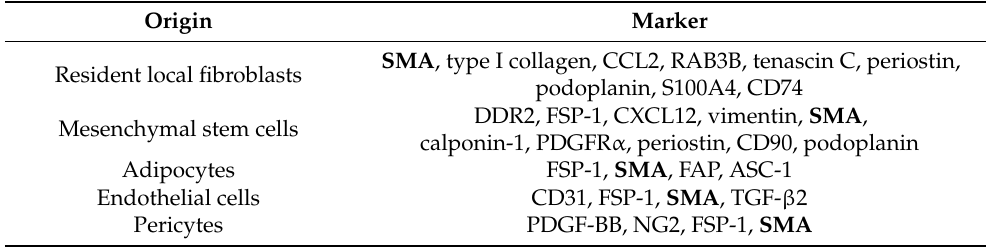
Table 2. Markers of CAFs according to their origin.